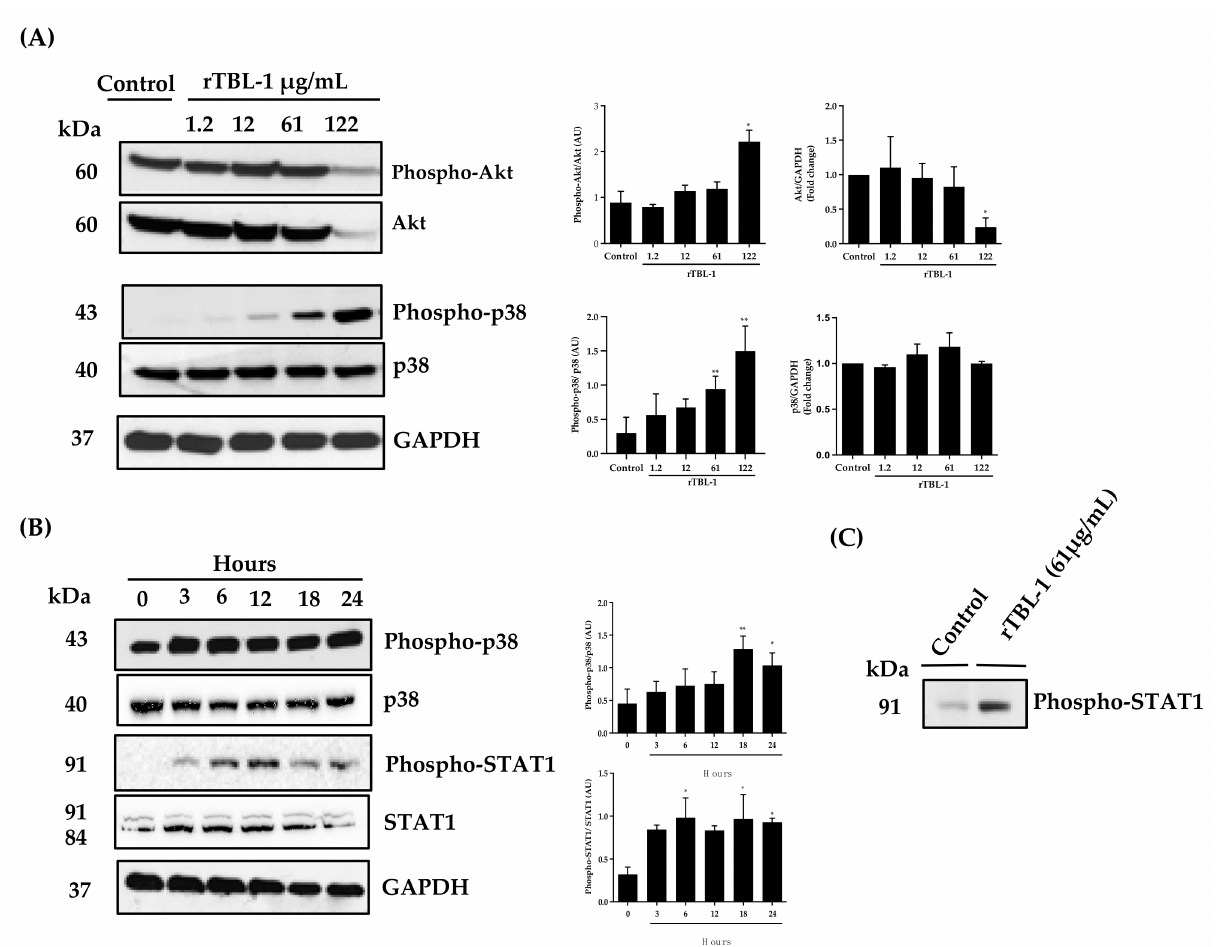
Figure 6. Effect of rTBL-1 on p38 and STAT1 activation in SW-480 colon cancer cells. ( A ) Representa- tive Western blot of phosphorylated and nonphosphorylated Akt and p38 proteins after treatment with 1.2, 12, 61, and 122 µ g protein/mL of rTBL-1 for 24 h. The phosphorylation level of each protein was determined by the ratio of the density of the phosphorylated band over the total band. ( B ) Representative Western blot of phosphorylated and total p38 and STAT1 proteins when cells were treated with 61 µ g protein/mL of rTBL-1 for 0, 3, 6, 12, 18, and 24 h. ( C ) Effect of rTBL-1 on STAT1 (Tyr 701) phosphorylation after 3 h in 61 µ g protein/mL of rTBL-1. Dunnett post hoc analyses; (*) p ≤ 0.05 and (**) p ≤ 0.01 indicate the significant difference compared with control